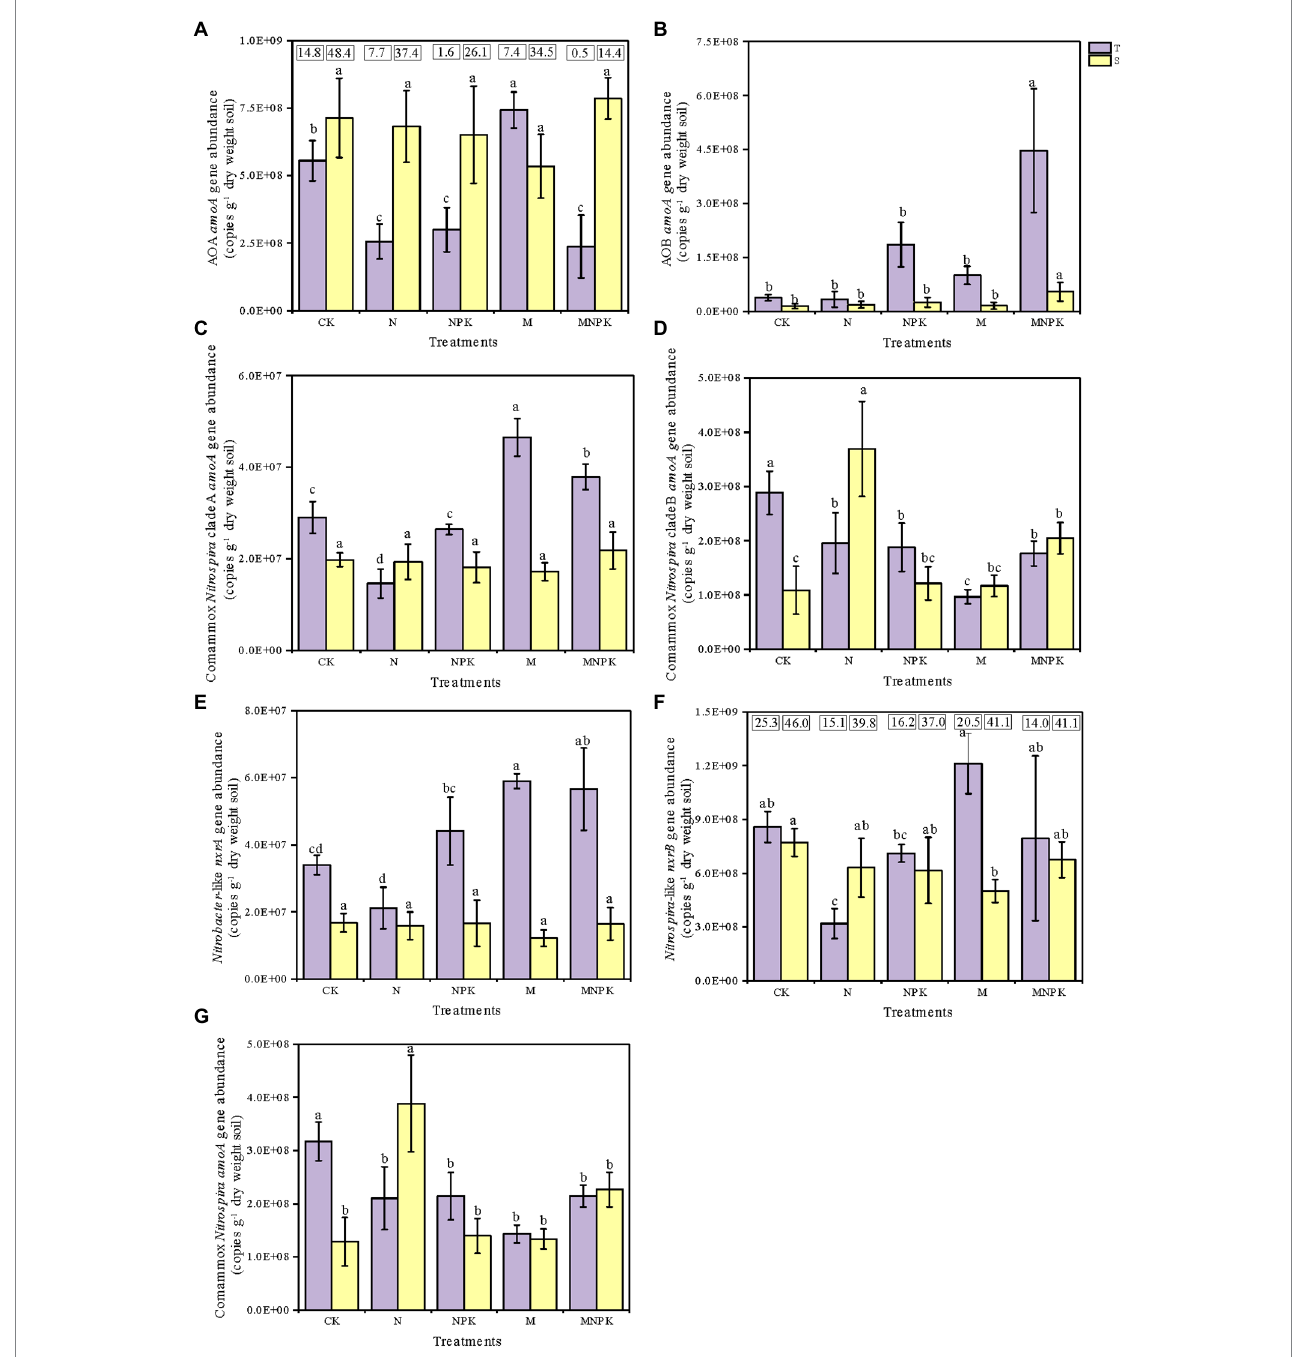
FIGURE 2 Abundances of nitrifier genes under different long-term fertilization regimes. The amoA gene abundances of AOA (A) , AOB (B) , comammox Nitrospira clade A (C) , comammox Nitrospira clade B (D), total comammox Nitrospira (the sum of clade A and clade B amoA gene abundances) (G) , the nxrA gene abundance of Nitrobacter -like NOB (E) , and the nxrB gene abundance of Nitrospira-like NOB (F) were determined by qPCR analysis. The numbers in the panel (A,F) express the ratio of AOA to AOB and Nitrospira to Nitrobacter . The error bars in the columns represent the standard errors of the triplicated means. The different letters above columns indicate significant differences among different treatments (one-way ANOVA, Duncan test, P <0.05). T and S represent topsoil and subsoil,